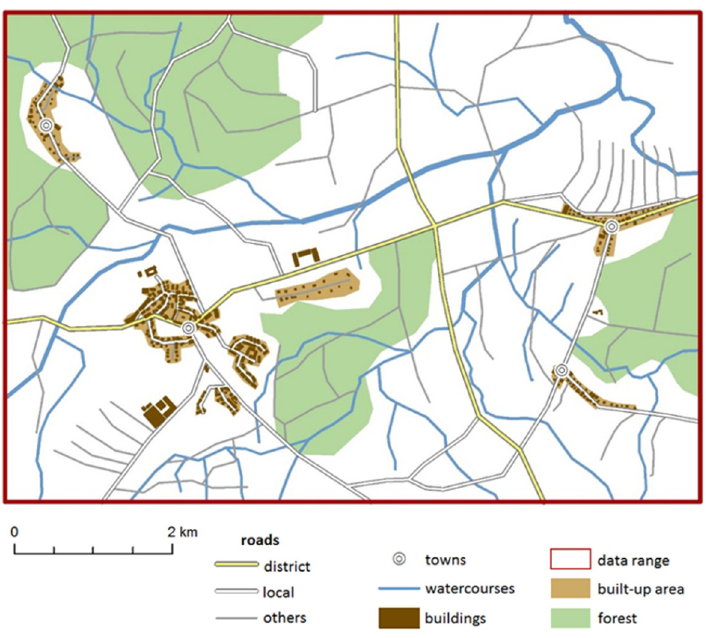
Fig. 1. Model data at the LoD10k (source: A. Fiedukowicz